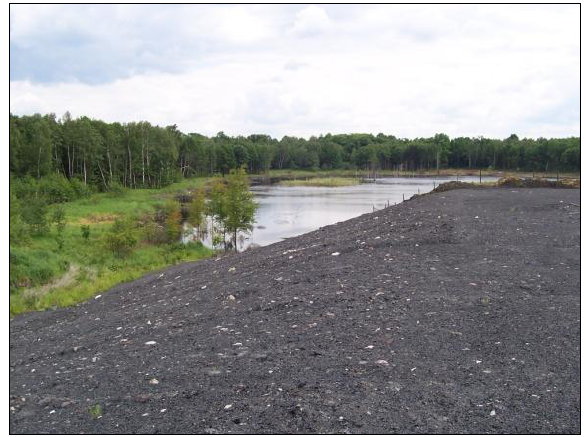
Fig. 6. „Aniołki” water reservoir near the „Knurów” hard coal mine ( E. Jaruchiewicz )